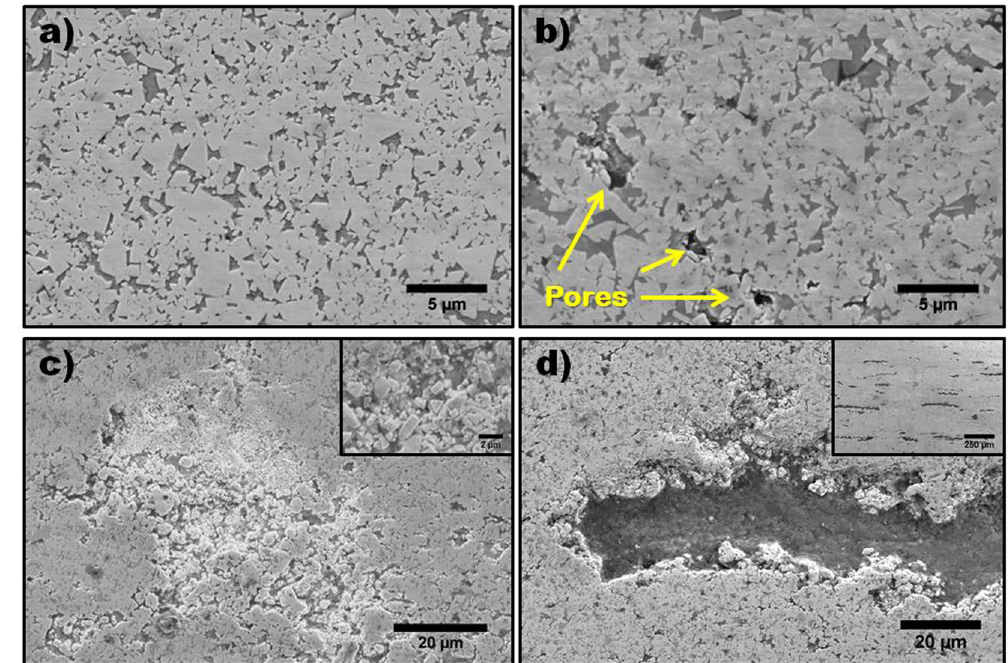
Figure 2. SEM of salient microstructural features in WC-Co and nanocomposite samples; ( a ) Dense WC-Co microstructure, ( b ) WC-Co-2ND exhibiting increased presence of micro pores, arrows denote examples of pores, ( c ) WC-Co-5ND showing poorly sintered regions with high porosity, Inset: high magnification image of pores in WC-Co-5ND, the region appears to have collapsed and bonding between WC and the Co binder is poor, ( d ) High aspect ratio porous region in WC-Co-10ND, Inset: Lower magnification image showing highly oriented nature and prevalence of high aspect ratio porous